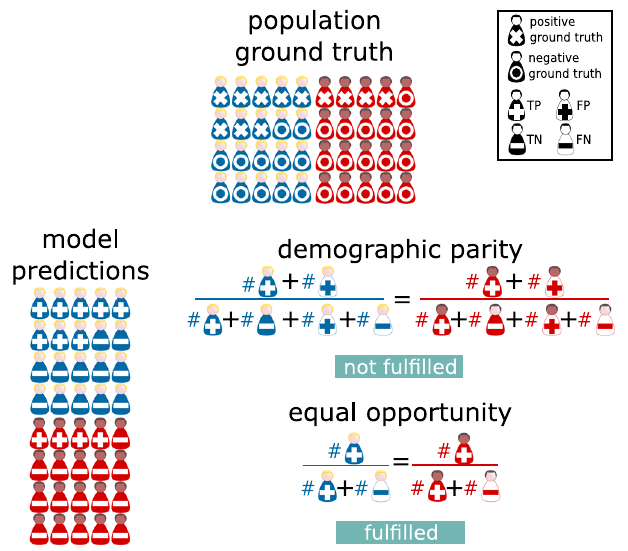
Fig. 1 | Group-fairness metrics. Here we include a toy-example in the context of disease classi fi cation, where two sub-populations characterized by different pro- tected attributes (in red and blue) present different disease prevalence (40% and 20% for blue and red subjects respectively, top row, x marks positive cases). A model optimized for discriminative performance was assessed on a test set achieving 100% accuracy (bottom row left side, + marks positive predictions). Algorithm fairness was audited according to two common metric choices (bottom row, right side). In this case, as a consequence of the difference in disease fre- quency, the model would not ful fi ll the demographic parity criterion (bottom row, right side) since the positive prediction rates vary between sub-groups : 40% (8 positive predictions over 20 cases) for the blue sub-group vs. 20% (4 positive predictions over 20 cases) for the red sub-group. On the other hand, the model would ful fi ll the equal opportunity criterion, as true positive rates match for both sub-groups reaching the value of 100%: 8 true positives out of 8 positive ground truth cases for the blue sub-group and 4 true positives out of 4 positive ground truth cases for the red sub-group . FN false negatives, FP false positives, TN true negatives, TP true positives. See legend-box with symbols on the top right corner.